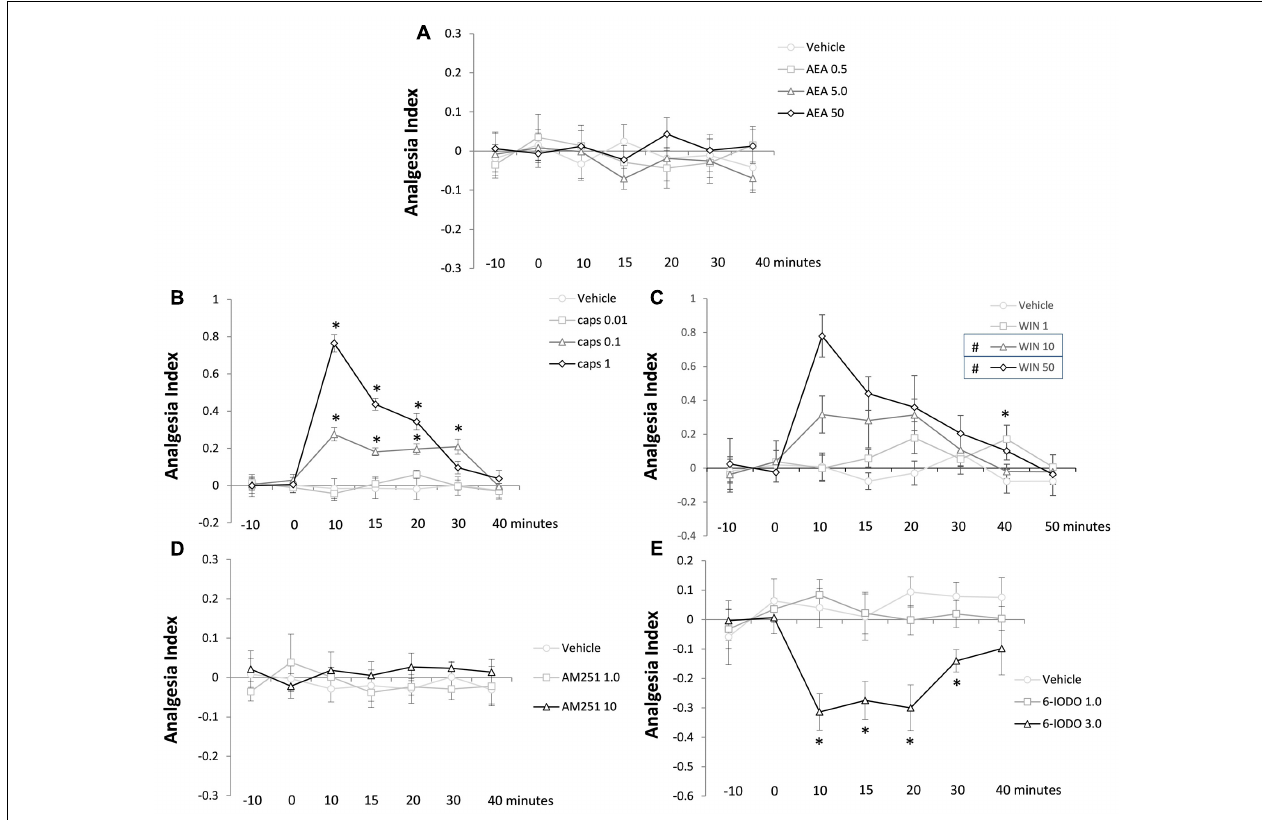
FIGURE 3 | Lack of effects of AEA (A) and AM251 (D) and effects of capsaicin (B) , WIN (C) , and 6-IODO (E) injected into the dPAG on the TFL of mice exposed to the tail-flick test. Microinjection was performed at “zero” time. N = 4–7. Dots in the line chart represent mean ± SEM. Two-way ANOVA (repeated measures) followed by Duncan post hoc test. ∗ P < 0.05 compared to vehicle-treated animals. # P < 0.05 compared to vehicle-treated animals until 20 min